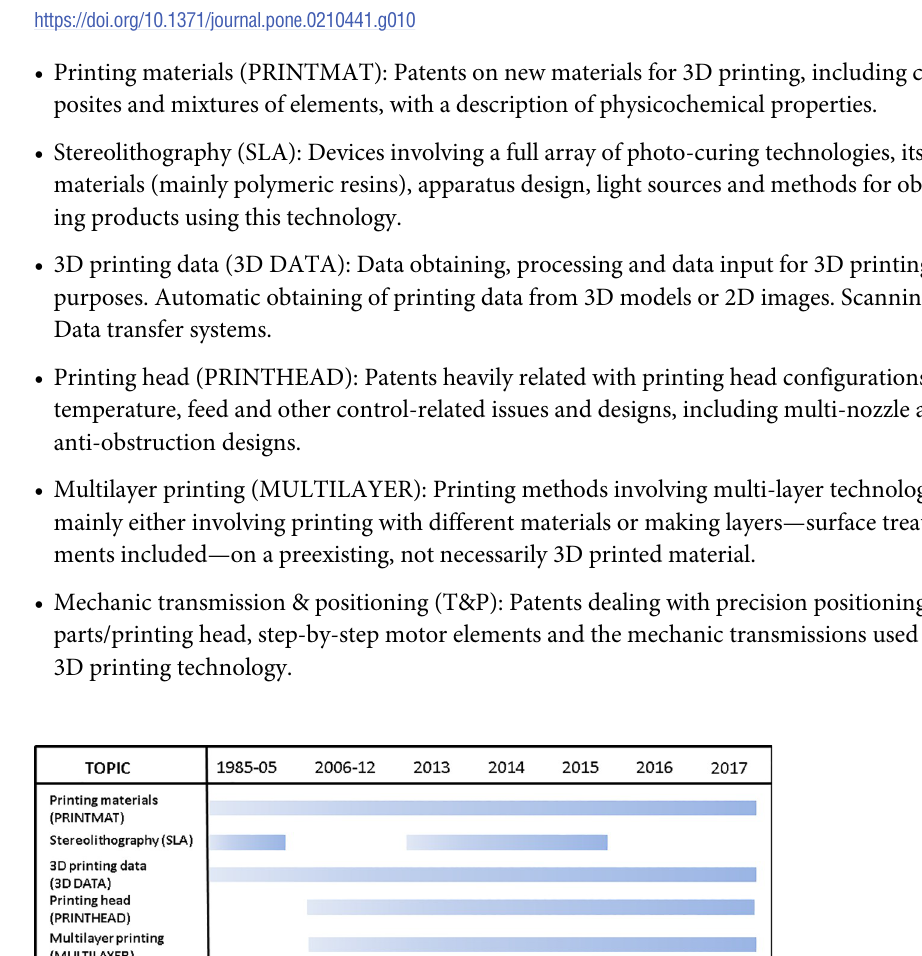
Fig 10. Topic structure corresponding to year 2014 data. 7-topic solution produced by LDA model with data corresponding to year 2014.